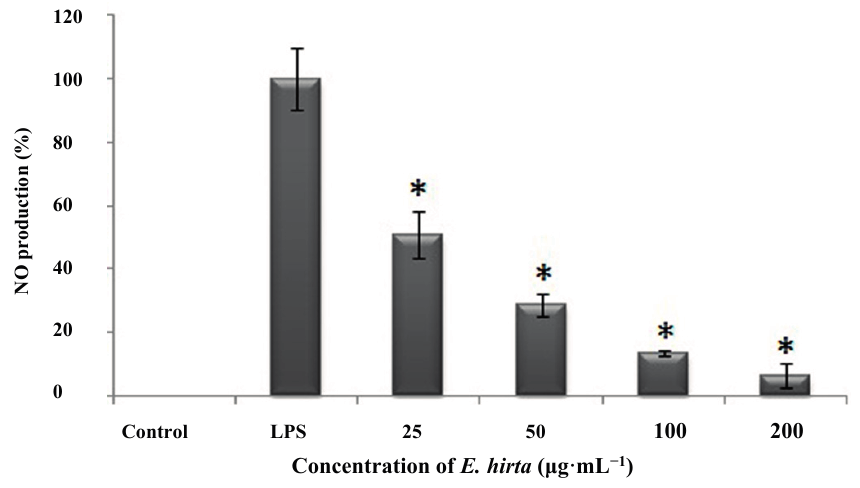
Figure 5. Effect of ethanol extract of E. hirta on LPS-induced NO levels in mouse macrophages (RAW 264.7 cells). Cells (1 × 10 5 ) were incubated with E. hirta (0, 25, 50, 100 and 200 μ g/mL) for 1 h, then with LPS (1 μ g/mL) for 24 h. Culture supernatants were subsequently isolated and analyzed for nitrite levels. Data represent the means ± SDs of three independent experiments. * p < 0.05 vs. the non-treated LPS induced